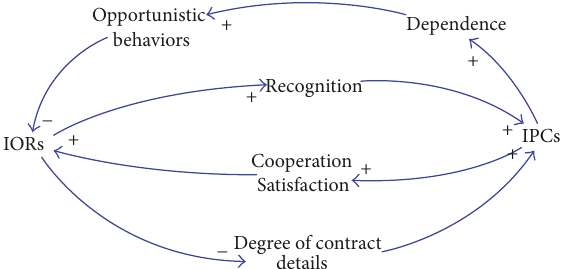
Figure 1: Causal loop diagram of interrelations between IORs and